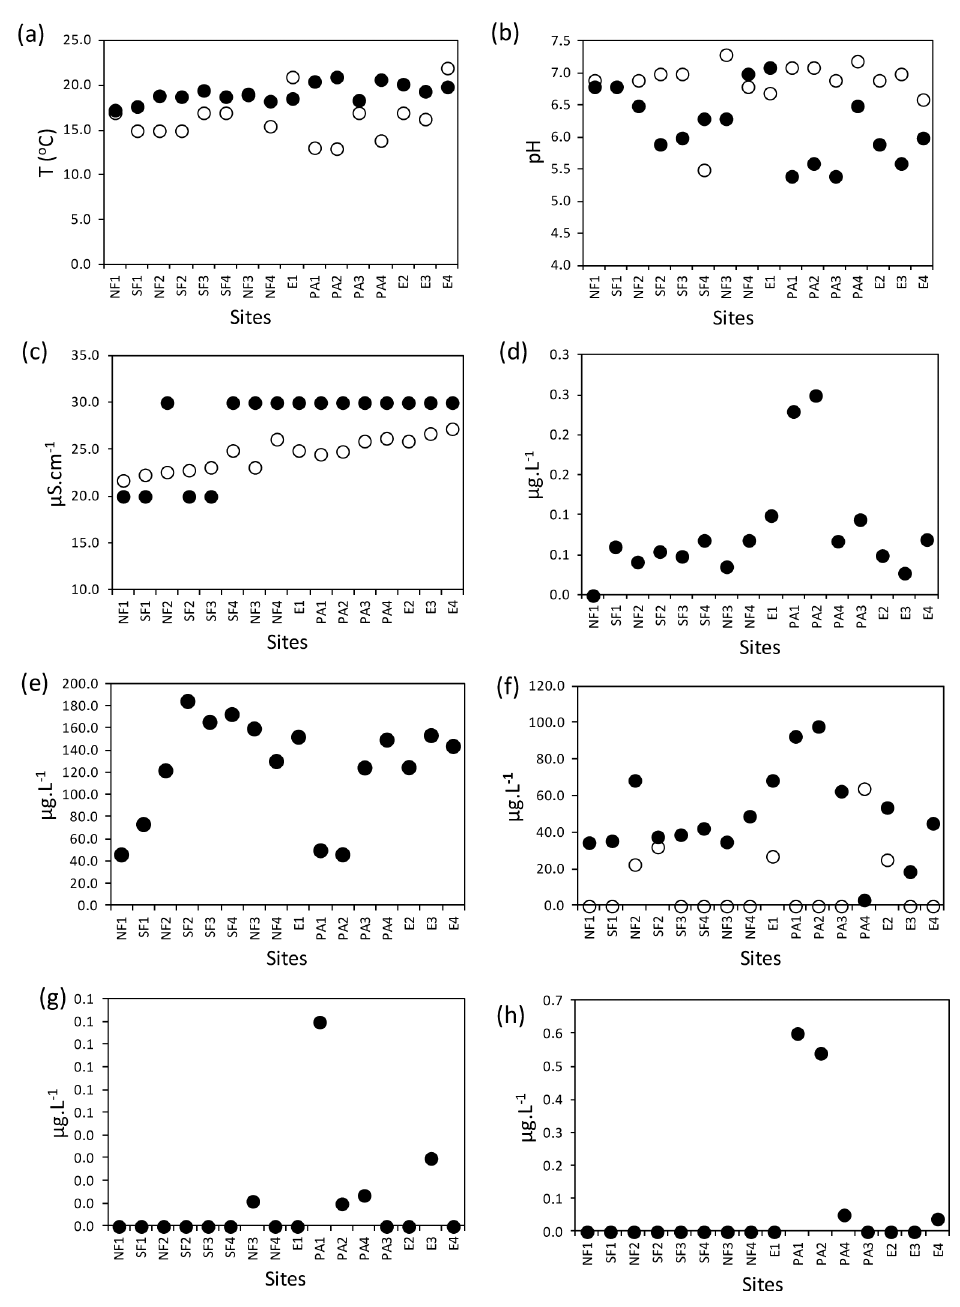
Figure 4. Longitudinal variation of the most important physicochemical parameters related to the environmental gradient along the Paraitinga River for the dry and rainy seasons. Rainy season – filled circles; dry season – open circles. (a) – Temperature; (b) pH; (c) conductivity; (d) NO 3- ; (e) dissolved organic phosphorus; (f) total phosphorus; - ; (h) NH + . NF - native forest; SF – secondary forest; EU – eucalyptus; PA- (g) NO 2 4